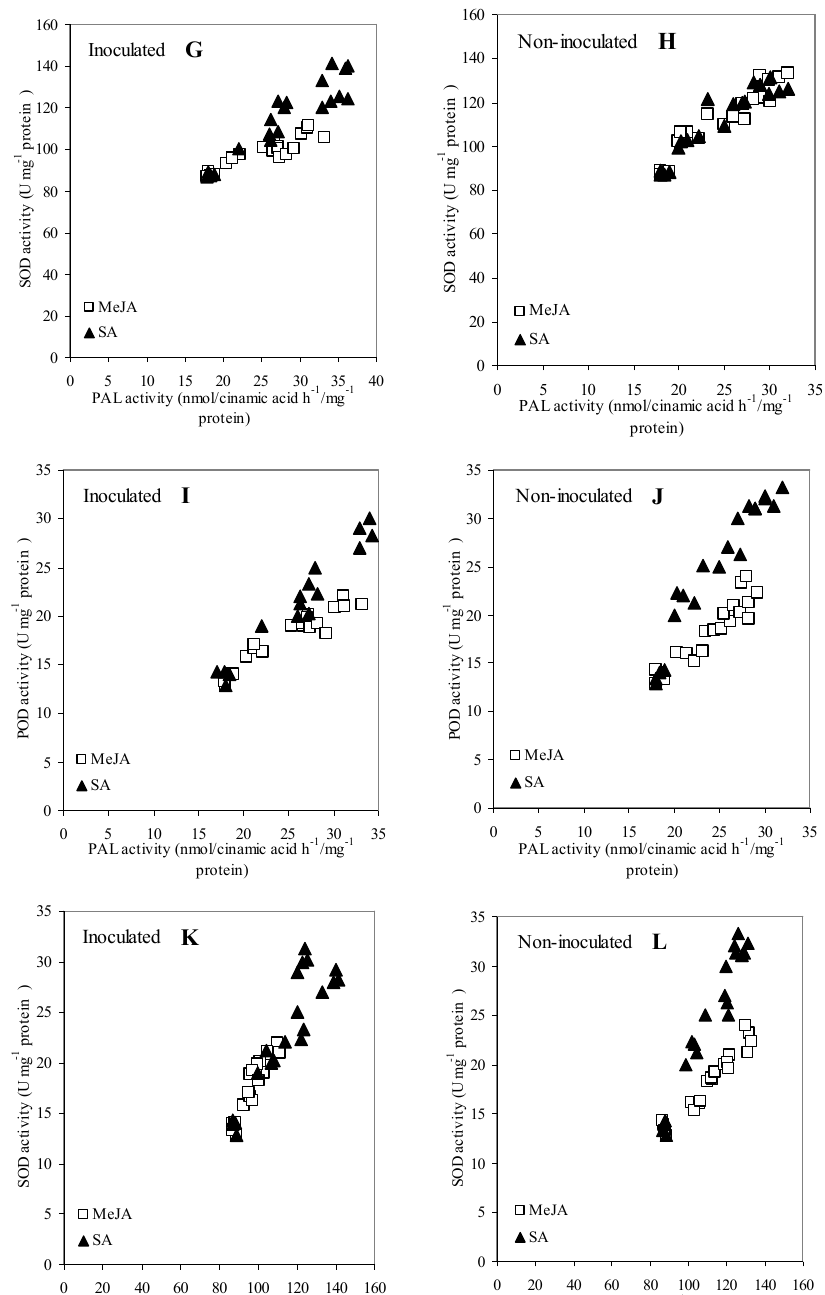
Figure 5. Relationships between fruit firmness (FF) and total soluble phenol content (TSPC) ( A , B ), FF and total antioxidant capacity (TAC) ( C , D ), TAC and phenylalanine ammonia-lyase (PAL) activity ( E , F ), PAL activity and peroxidase (POD) activity ( G , H ), PAL activity and superoxide dismutase (SOD) activity ( I , J ), POD activity and SOD activity ( K , L ) in treatments with methyl jasmonate (MeJA, 0.4 mmol L −1 ) and salicylic acid (SA, 2 mmol L −1 ) separately for inoculated ( A , C , E , G , I , K ) and non-inoculated treatments ( B , D , F , H , J , L ) on cultivar ‘Bergarouge’ apricot fruit.